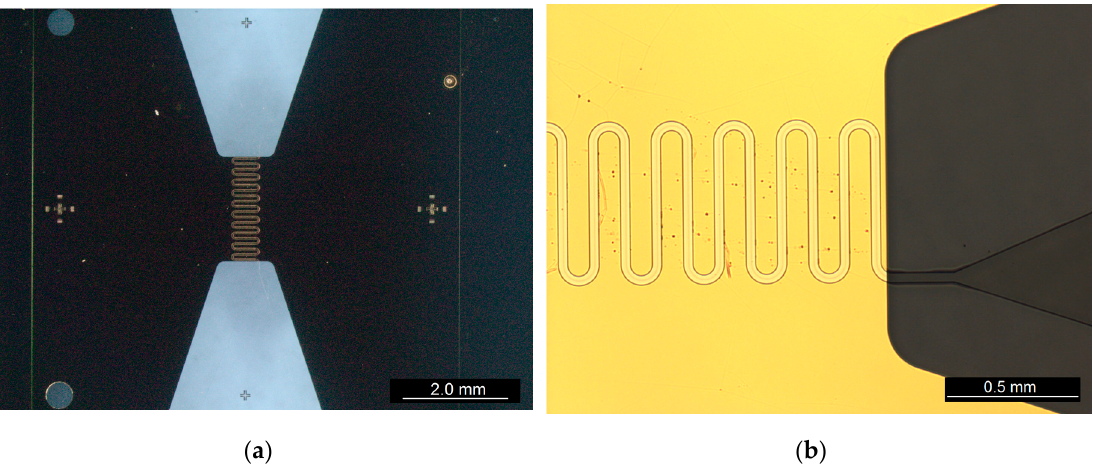
Figure 3. ( a ) The bow-tie-shaped sensor with central microfluidic channel; and ( b ) close-up showing the serpentine microfluidic channel with funnelled inlet/outlet.